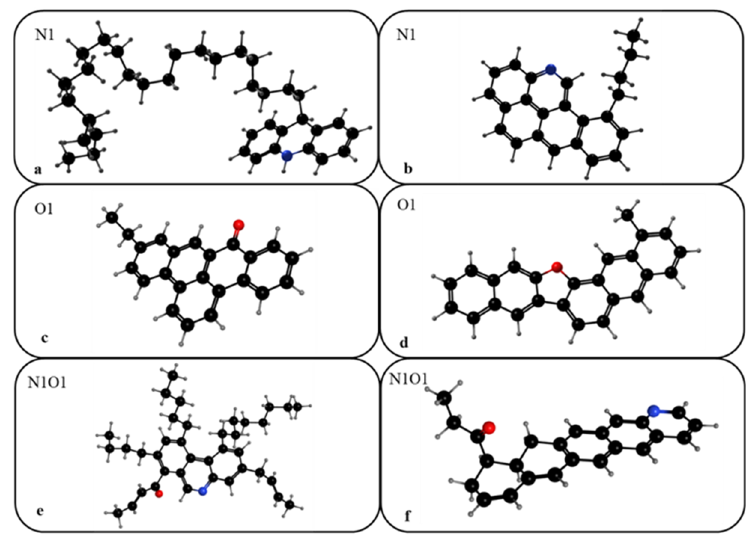
Figure 14. The 3D molecular structure of several representative heteroatom compounds. (SLO-LH and SFEO-LH: ( a , c , e ); SLO-SH and SFEO-SH: ( b , d , f ). The red balls represent oxygen atoms and the blue balls represent nitrogen atoms.).